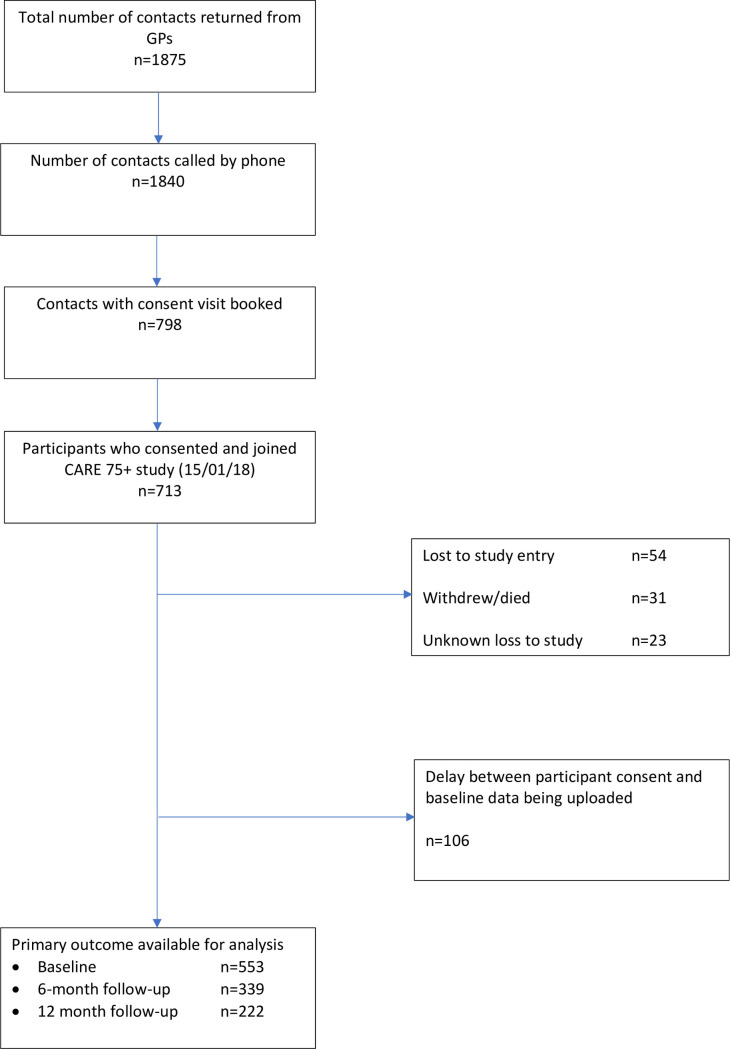
STROBE flow diagram.